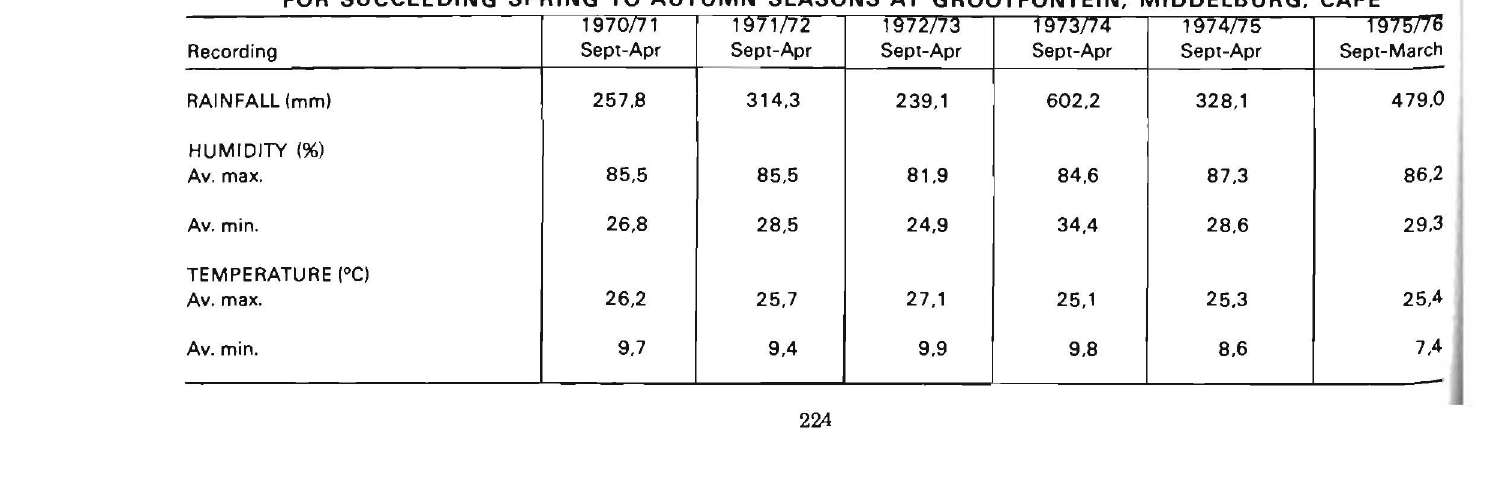
Table 1: TOTAL RAINFALL, AVERAGE MAXIMUM AND MINIMUM HUMIDITY AND AMBIENT TEMPERATURES FOR SUCCEEDING SPRING TO AUTUMN SEASONS AT GROOTFONTEIN, MIDDELBURG,